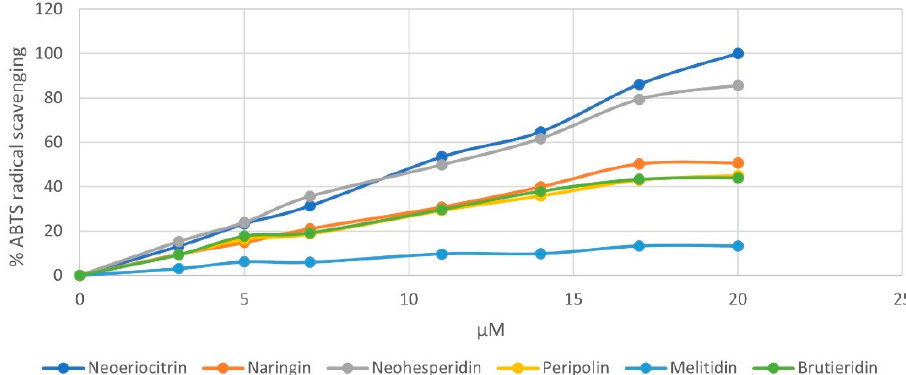
Figure 4. Reactivity behavior of pure flavonoids from bergamot against ABTS radical ion.